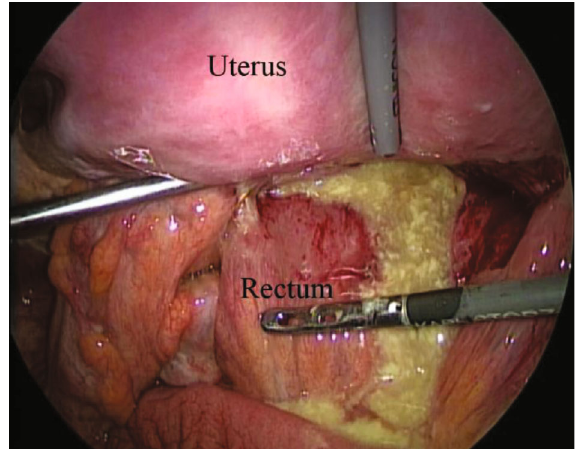
Figure 2: An intraoperative laparoscopic image of the abscess, which was found in the pouch of